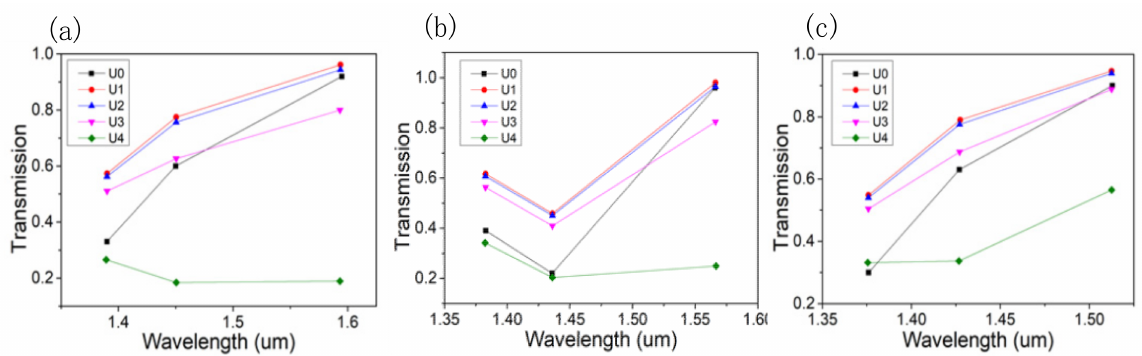
Figure 8. Transmittance of different ports at the peak wavelength of the transmission spectrum after the upper dielectric column being reduced ( a ) port A, ( b ) port B, and ( c ) port